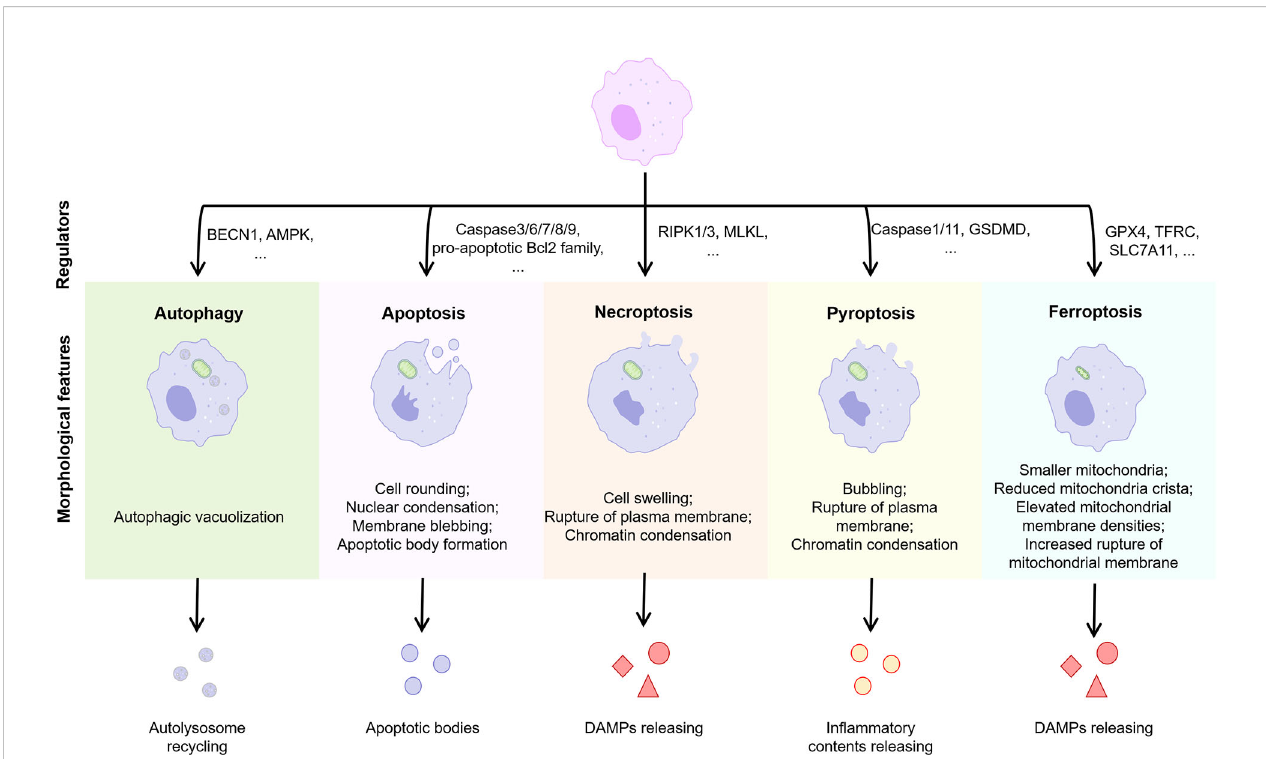
FIGURE 4 Features of different types of PCD. Normal cells are induced to different forms of death by different stimuli or signals, including autophagy, apoptosis, necroptosis, pyroptosis, and ferroptosis. Different PCD types exhibit different morphological features and play an important regulatory role in the progression of in fl ammation. BECN1, beclin 1; AMPK, adenosine 5 ’ -monophosphate (AMP)-activated protein kinase; RIPK, receptor-interacting protein kinase; MLKL, mixed lineage kinase domain-like; GSDMD, gasderminD; DAMPs, damage associated molecular patterns; GPX4, glutathione peroxidases 4; TFRC, transferrin receptor; SLC7A11, solute carrier family 7 member